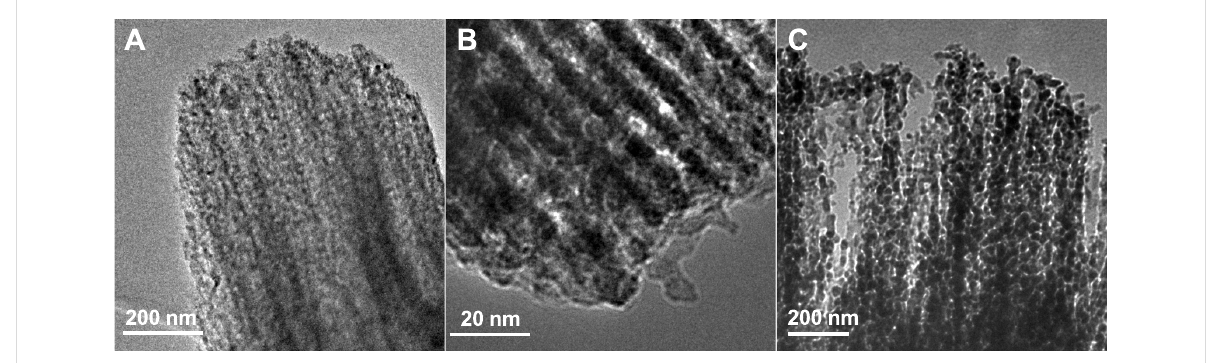
Figure 3: Transmission electron microscope (TEM) images of as-prepared LiNbO 3 /SBA-15 composite (A, B), and after the first treatment with LiOH solution (C).